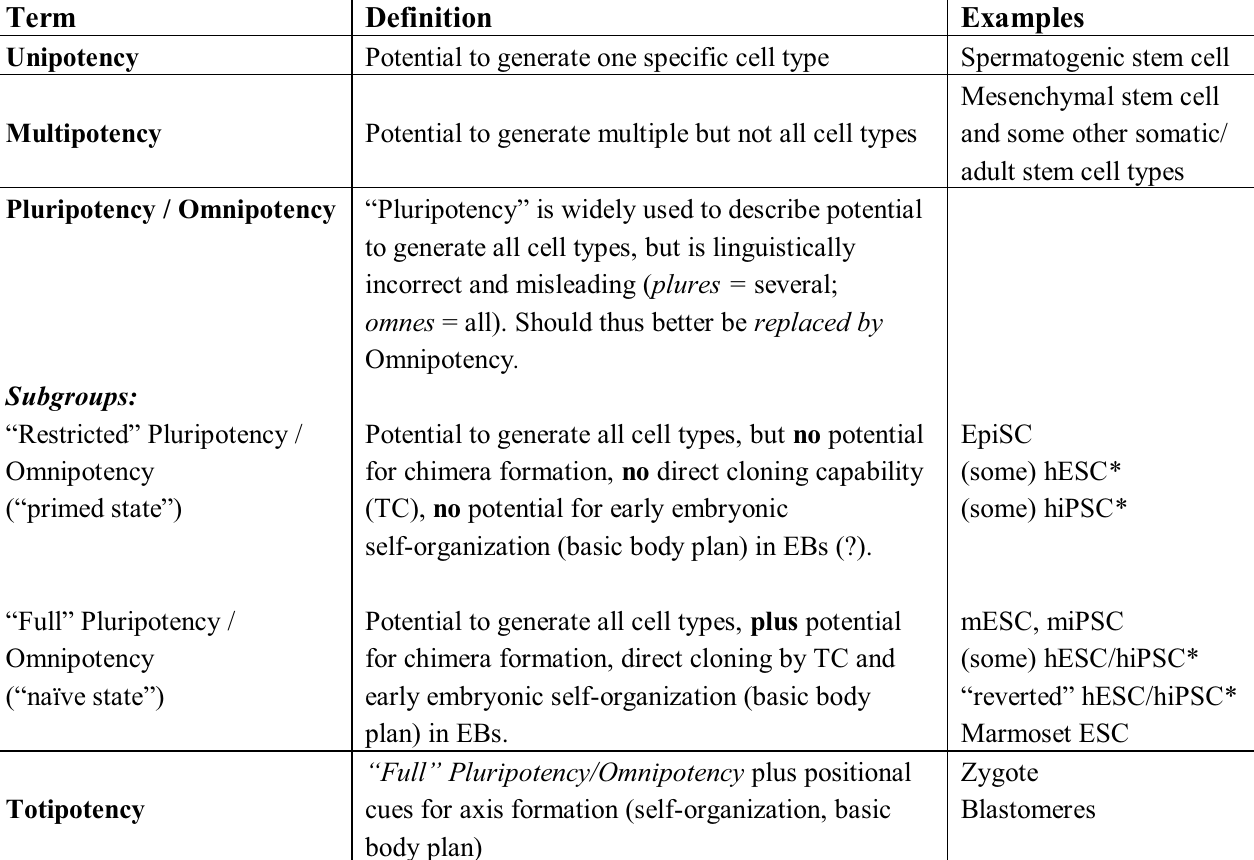
Table 1. Terms Used to Describe Stem Cell